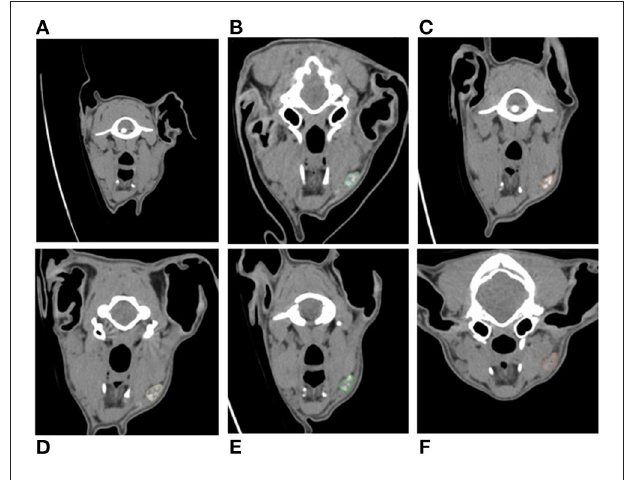
FIGURE 1 | Serial cross-sectional CTL images in a transverse plane set in a soft tissue window of the same dog compared to pre-injection (A) . Images ( B–F ) demonstrate contrast enhancement present within the right dorsolateral mandibular lymph node (colored outline) at day 1 post-injection (B) , day 2 post-injection (C) , day 4 post-injection (E) , and day 10 post-injection (F) .